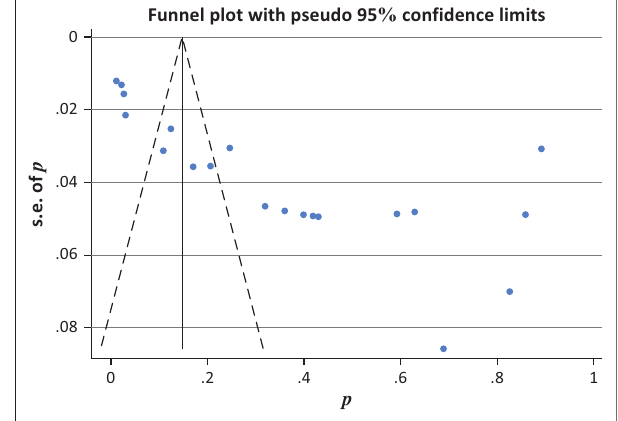
FIGURE 6: Funnel plots from